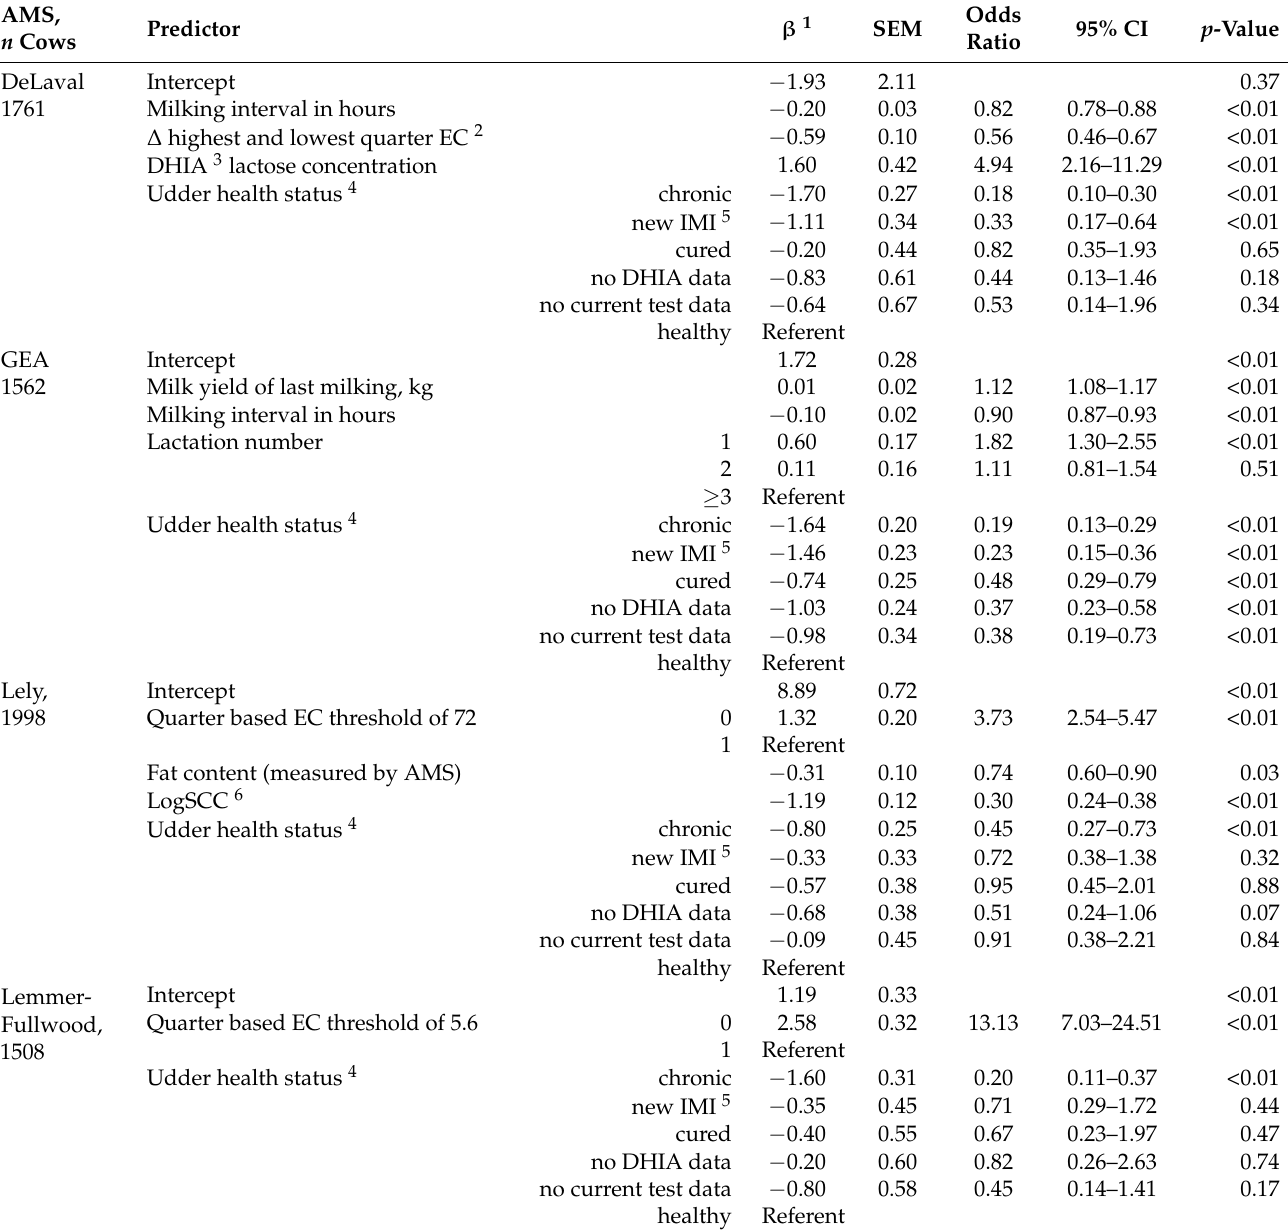
Table 7. Factors improving the specificity (outcome: healthy cows, i.e., no clinical mastitis, without alert) on a cow level, including only healthy cows and DHIA as well as AMS data, in a cow-level multivariable logistic regression analysis with herd as random